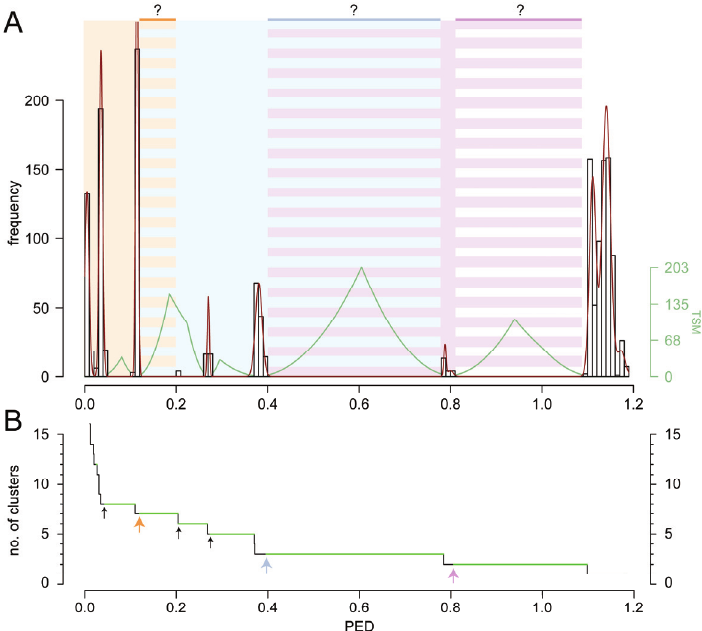
Figure 1. Filovirus-wide pairwise evolutionary distance (PED) distribution and thresholds for virus clustering. ( A ) Shown is a frequency distribution (white bins) of around 1,500 PED values, which estimate the average number of amino acid substitutions per site between each pair of viruses. A mixture model (red curve) was fitted to the PED distribution and used to calculate a threshold support measure (TSM, green). For details on threshold delineation see [1]. A threshold candidate (peak in the TSM measure) may be used to group the viruses into clusters in which virus pairs with a PED not exceeding the threshold join the same cluster. The three candidates with highest TSM scores were used to hierarchically group the 56 filoviruses at three levels comprising seven, three, and two clusters, respectively. Each of the thresholds is located within a continuous PED range for which no PED values are observed with the current filovirus sampling (striped background shading). PED values in these ranges (if sampled in the future) could be associated with either the classification level delimited by the respective threshold (intra-cluster distances) or with the next higher level (inter-cluster distances). The actual PED values of the thresholds are thus uncertain (bright-colored horizontal bars and question marks); for simplicity we selected the values (0.120, 0.396, and 0.806) that correspond to the smallest value within the respective PED range. ( B ) The change in the number of derived clusters with respect to the value of the PED threshold candidate is shown. For each threshold candidate a continuous PED range with optimal clustering cost of zero (no intra-cluster PED values exceed the threshold) is highlighted in green. The six threshold candidates considered in this study show the following PED ranges (from left to right): 0.044–0.109, 0.120–0.203, 0.204–0.267, 0.274–0.369, 0.396–0.783, and 0.806–1.097. The three threshold candidates used in (A) are indicated by colored arrows; three alternative PED thresholds for the species level are shown by black arrows. Note that another clustering (12 clusters) with zero cost was not considered in this study because of the marginal PED range and low TSM support of the associated threshold (PED of